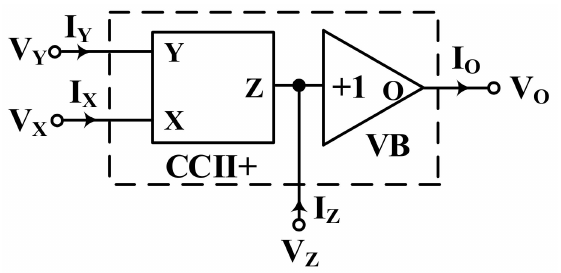
Figure 2. Implementation of CFOA given by a CCII + and a VB.